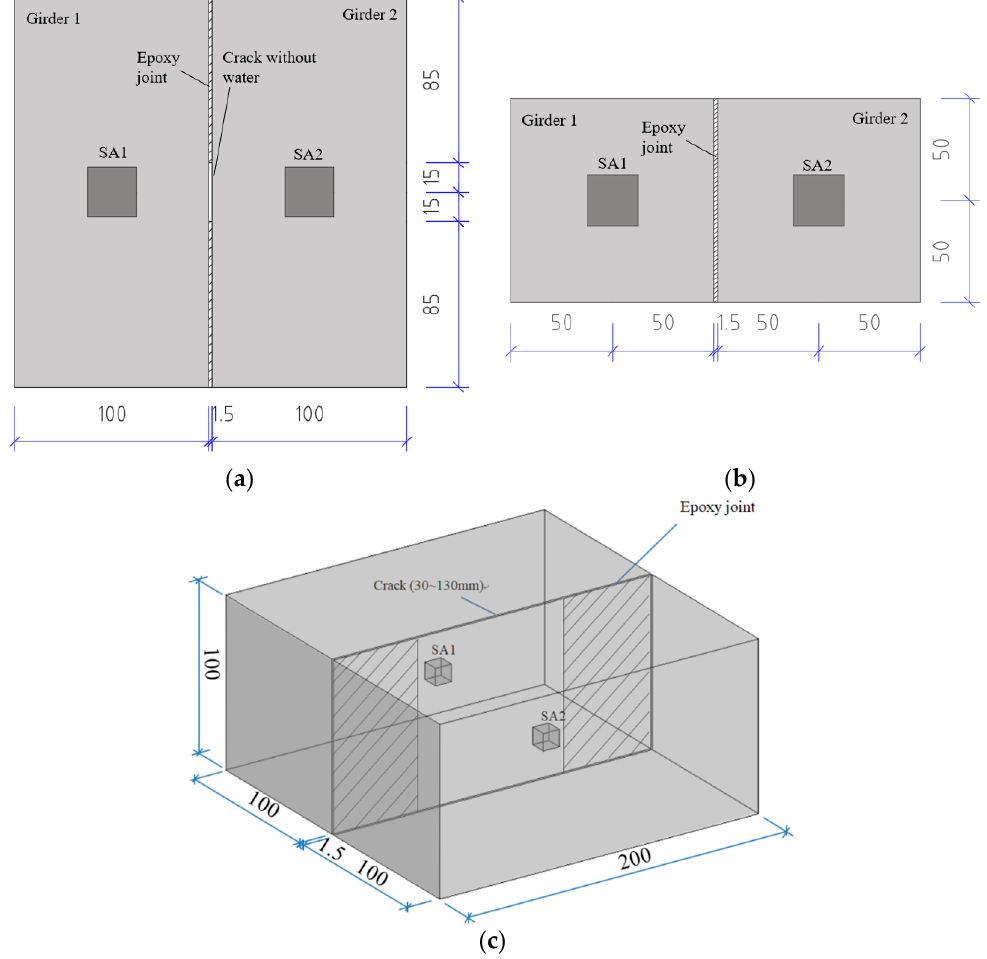
Figure 3. Design of the test specimen (unit: mm). ( a ) The plan view. ( b ) The elevation view. ( c ) Three-dimensional view.